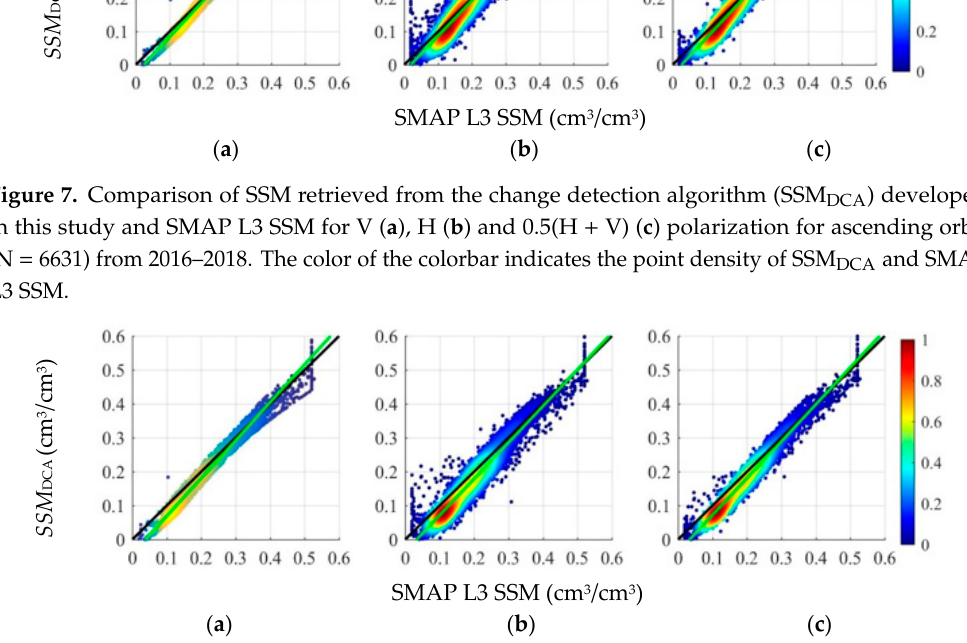
Figure 8. Comparison of SSM retrieved from the change detection algorithm (SSM DCA ) developed in this study and SMAP L3 SSM for V ( a ), H ( b ) and 0.5(H+V) ( c ) polarization for descending orbit (N = 6631) from 2016–2018. The color of the colorbar indicates the point density of SSM DCA and SMAP L3 SSM. Table 2. The fitted coefficient and statistical error of SMAP L3 SSM and estimated SSM from SMAP L3 dataset based on the change detection algorithm developed here.